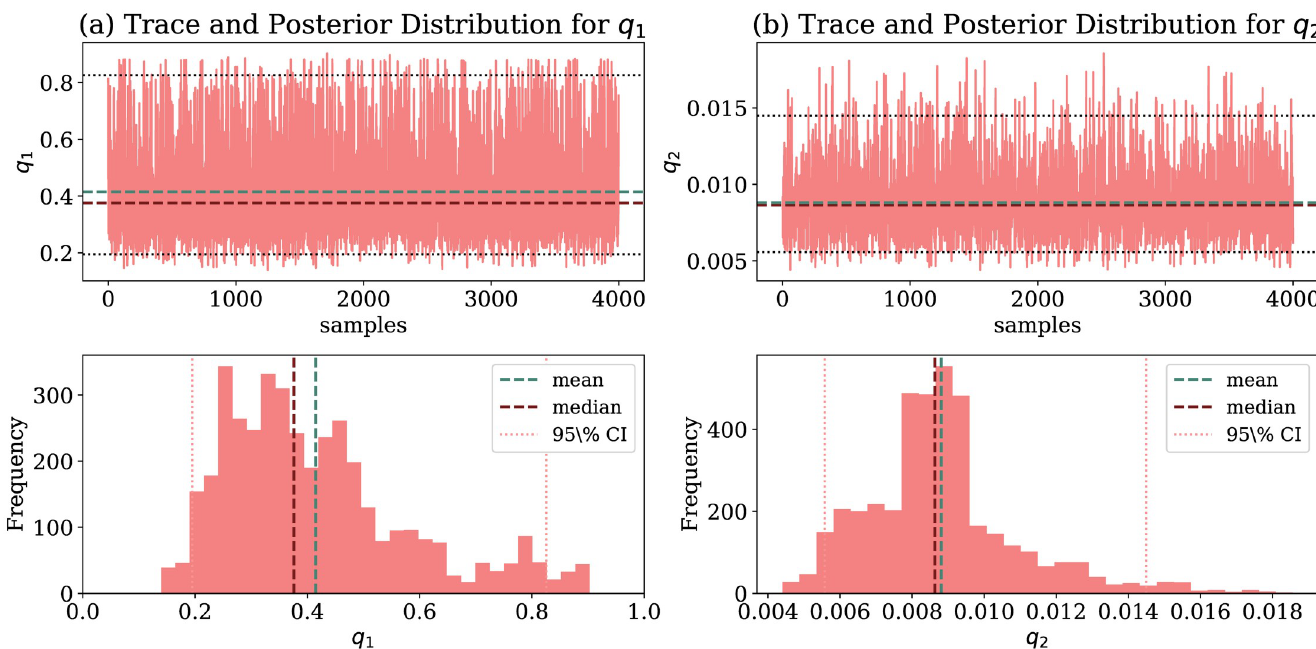
Fig 4. Mobility parameters estimated by our model for Fortaleza. Estimated values of mobility parameters q 1 and q 2 via MCMC and their resulting distributions. (a) q 1 (From 03/15 to 03/20). (b) q 2 (From 03/20 to 05/05).